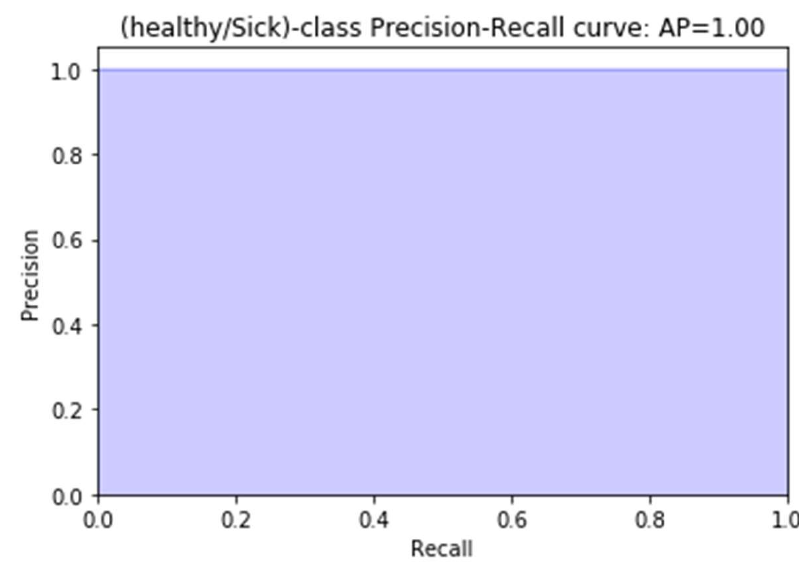
Figure 14. Confusion Matrix of our LinearSVC (SVM) shows how confident our classifier is for each prediction.